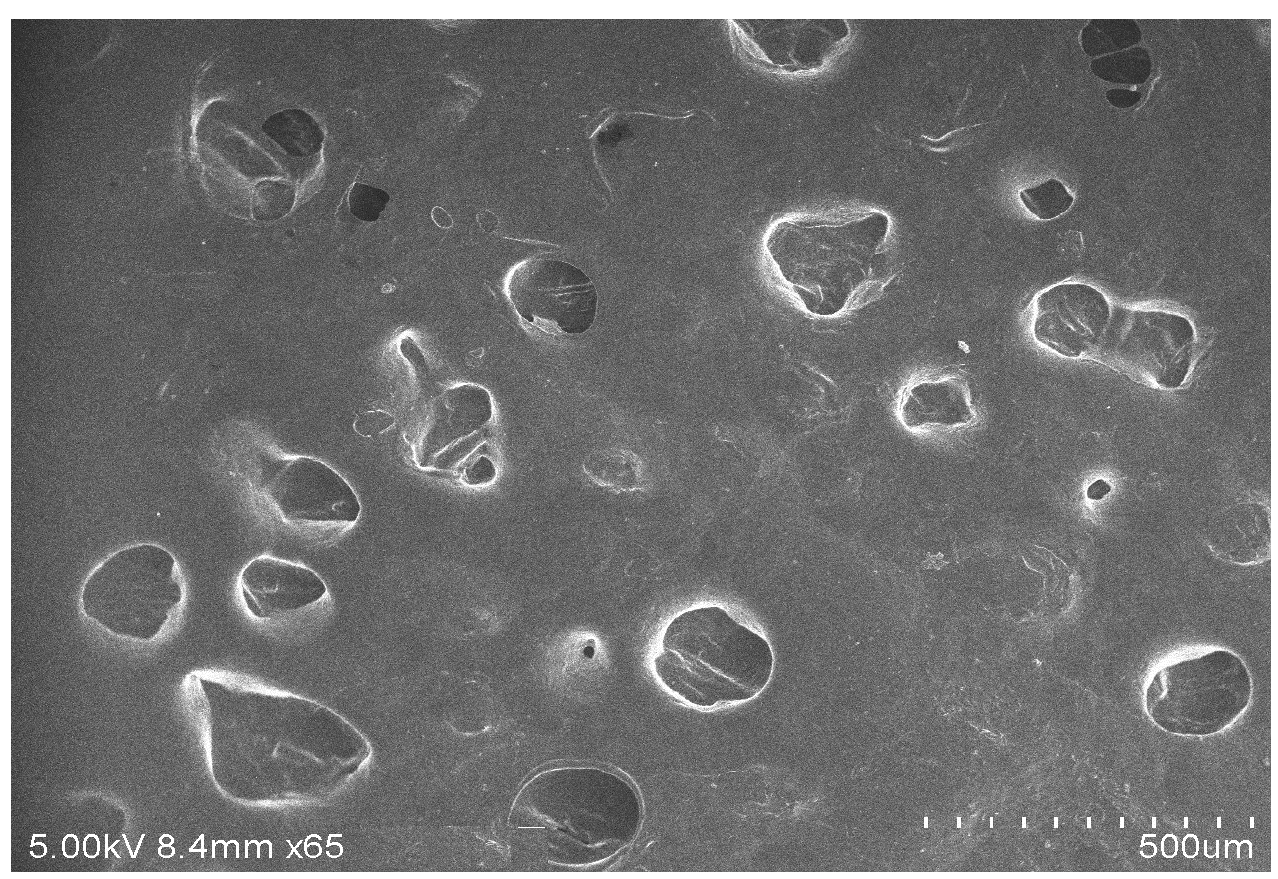
Figure 5. Surface morphology of P. granatum ethosome vesicles using a SEM.